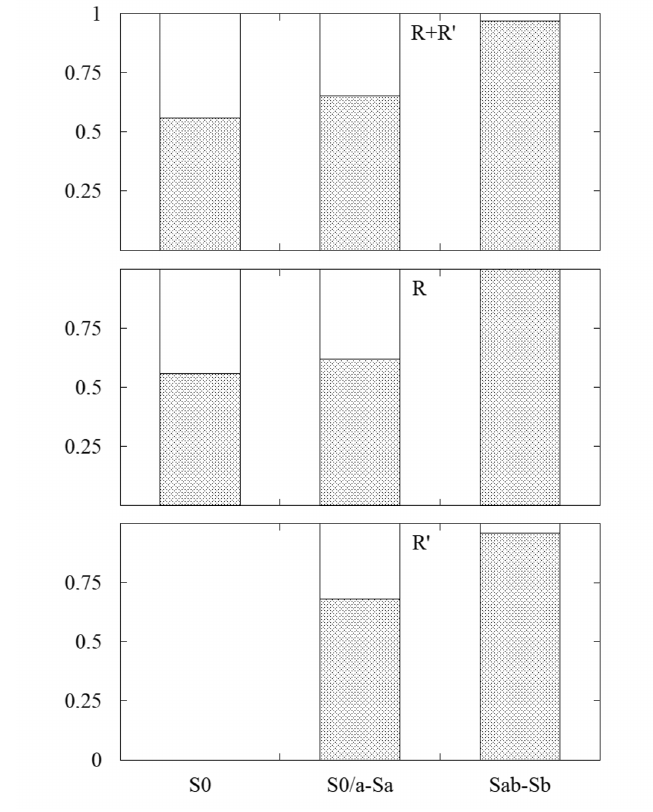
Fig. 1. The fraction of galaxies with UV-radiation in an outer ring ( shaded ) among the galaxies with outer stellar rings (4 (cid:22) m) for different morphological types: all the ring-like features, R+R ′ (the upper panel); only ‘pure’ rings, R (the middle panel), and pseudorings, R ′ (the bottom panel). For each type the total number of galaxies is normalized to